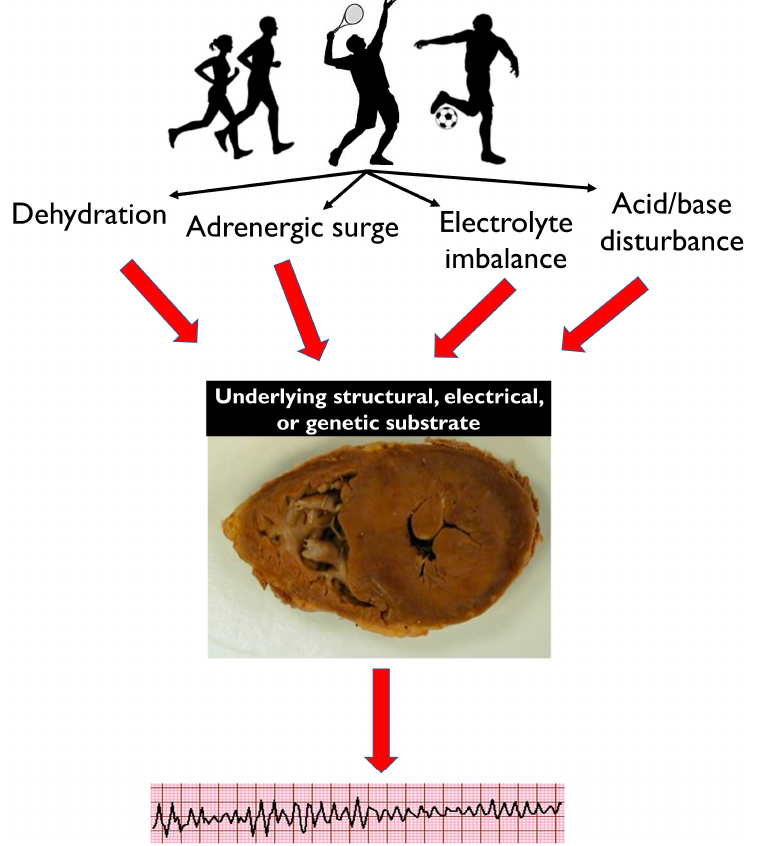
Figure 1. Dehydration, adrenergic surge, electrolyte imbalance and acid/base disturbance are common physiological effects of intense exercise. While these are well tolerated by healthy athletes, they may cause potentially fatal arrhythmias in individuals with an underlying electrical, structural or genetic pathological cardiac substrate. This image of a heart at post-mortem is suggestive of HCM, and this is used as an example.